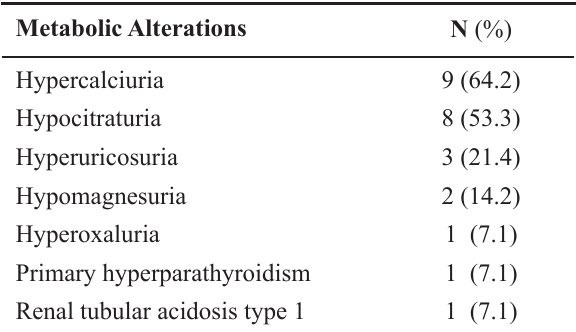
Table 2 – Outcome of metabolic assessments in patients with staghorn